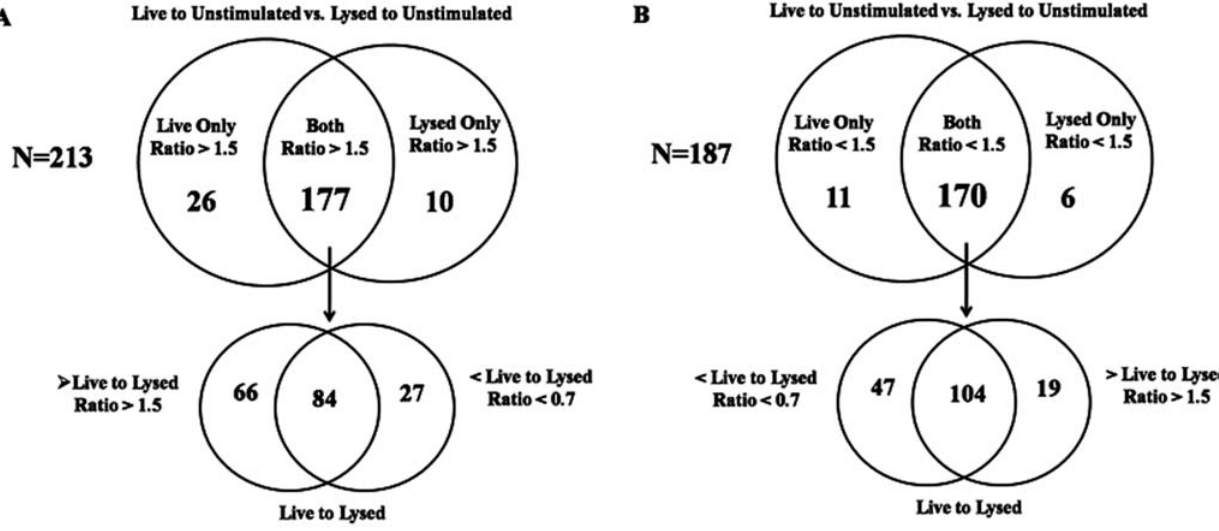
Figure 1. Distinct gene expression profiles obtained from human PBMCs stimulated with either live or lysed Borreliaburgdorferi . Genes whose normalized intensity values were deemed to be statistically significant in the PBMC array, and had a known biologic function, were used to determine the total number of genes whose intensity values were proportionately higher or lower in PBMCs in response to either live Bb and/or lysed Bb vs. unstimulated conditions. The top half of the Venn diagrams show the total number of gene transcripts that were more intensely or exclusively regulated by live and/or lysed Bb vs. unstimulated conditions (N=213 genes) (A), or less intensely or exclusively down-regulated by live and/or lysed Bb vs. unstimulated cells (N=187) (B). For similarly up-regulated (N=177) or down-regulated (N=170) genes, the arrows point down to a direct comparative analysis between live or lysed Bb generated gene intensity values. Genes in this category were further stratified depending on whether or not they were proportionately higher (live to lysed ratio . 1.5), lower (live to lysed ratio , 1.5) or equal between live vs lysed Bb stimulated cells.